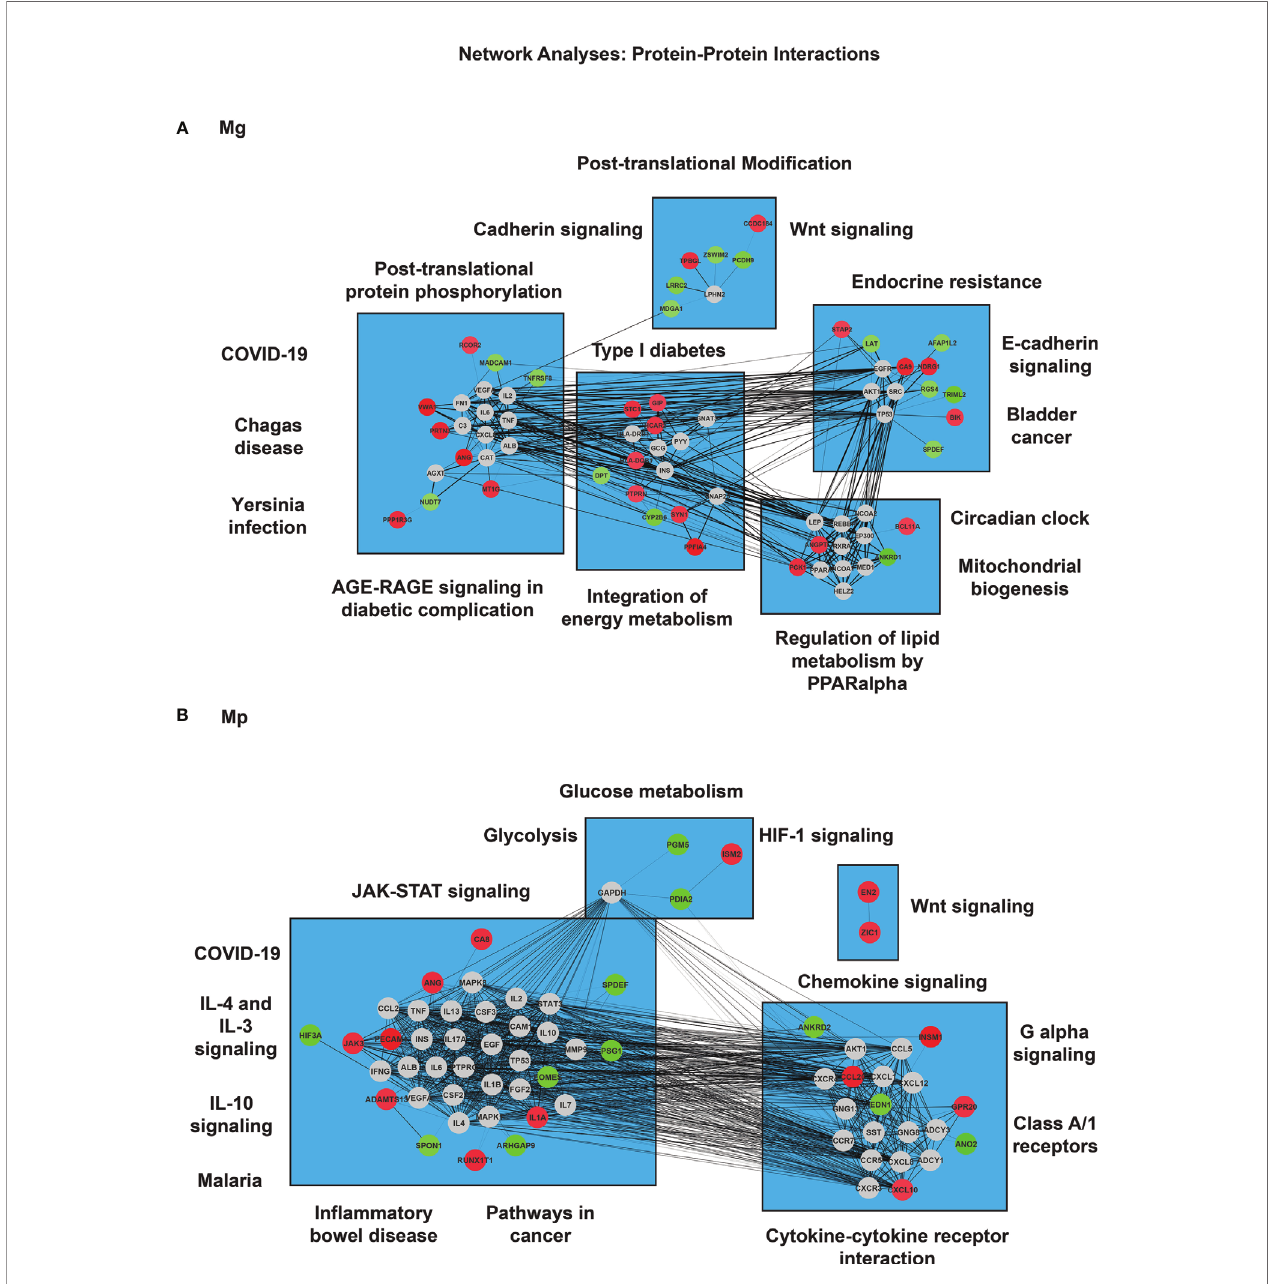
FIGURE 7 | Network analysis of protein-coding genes in M. genitalium (Mg) and M. pneumoniae (Mp). To determine functional cross-talk between both mycoplasma infected conditions, a gene-network analysis was carried out. (A) Gene-gene interactions in Mg and (B) Gene-gene interactions in Mp. The colors of the node correspond to either overexpression or knock-down expression (red and green, respectively). Gray nodes correspond to indirect interactions not obtained directly from the RNA-seq dataset. The width of the edge corresponds to the degree of evidence for the predicted